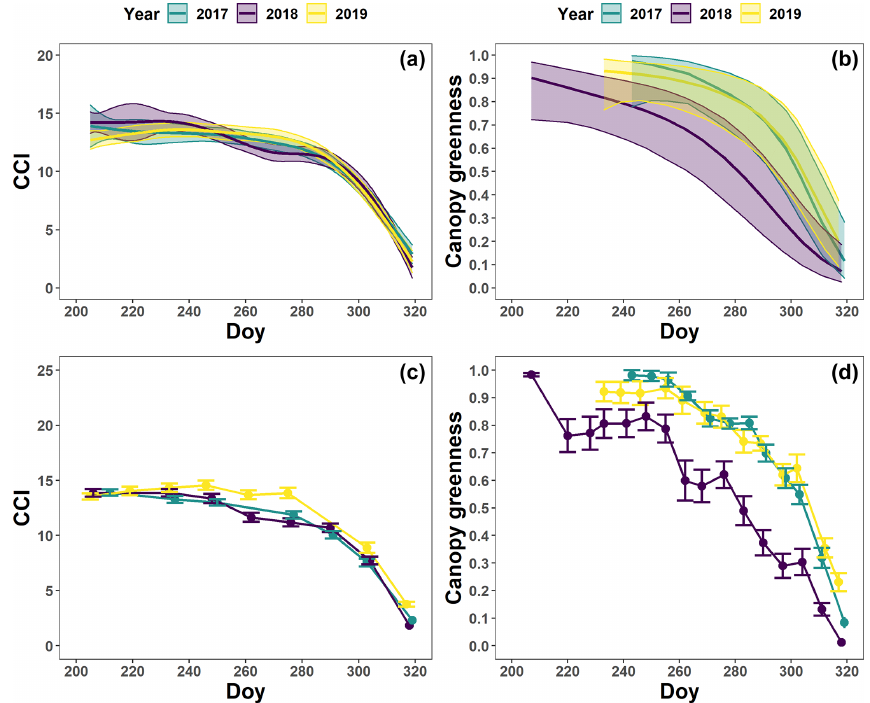
Figure 5. The generalized additive mixed model fits for the chlorophyll content index (CCI; n = 8; a ) and loss of canopy greenness ( n = 16; b ) of the mature Fagus sylvatica trees at the Klein Schietveld and Park of Brasschaat. The solid colored lines represent smooth terms, while the colored shaded bands around the smooth terms represent approximate 95% simultaneous confidence intervals (a) and 95% pointwise confidence intervals (b) . The dots and error bars represent the mean CCI (c) and mean canopy greenness (d) with standard errors. The colors represent the CCI or the loss of canopy greenness of the mature beech trees in 2017 (green), 2018 (purple) and 2019 (yellow).